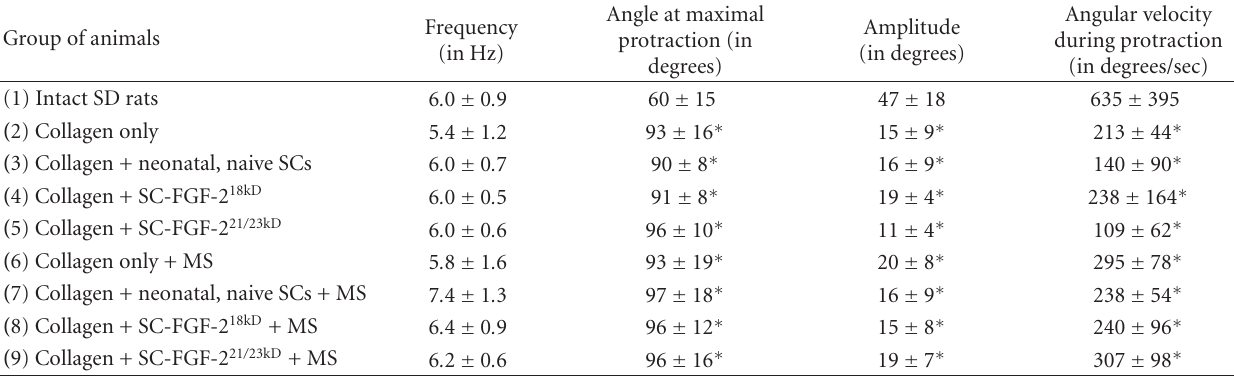
Table 1: Estimation of vibrissae function recovery. Vibrissae performance in unoperated rats ( Group 1: Intact ), in rats after transection of the right facial nerve followed by entubulation with collagen only ( Group 2: Collagen ), with collagen plus neonatal Schwann cells ( Group 3: C ollagen + naive SCs ), or with collagen plus genetically modified SCs (Groups 4 and 5). In groups 6–9 entubulations were followed by manual mechanical stimulation (MS) of the vibrissal muscles. Group of animals